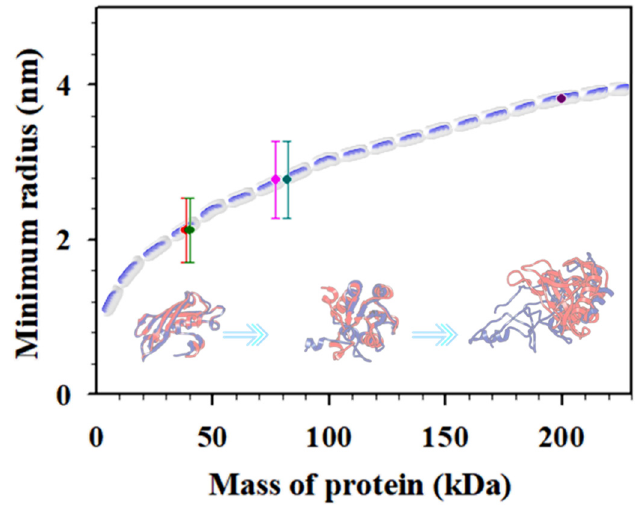
Figure 1. Plot of the minimum radius for proteins of different masses. The data points were estimated for NSE (monomer, 38.5 kDa), soluble fragment of cytokeratin 19 (CYFRA21 − 1, ~40 kDa), neuron-specific enolase (NSE, dimeric, 77 kDa), carbohydrate antigen 15 − 3 (CA 15 − 3, 82 kDa), and CEA (200 kDa). Inset: illustrative scheme of different protein masses.